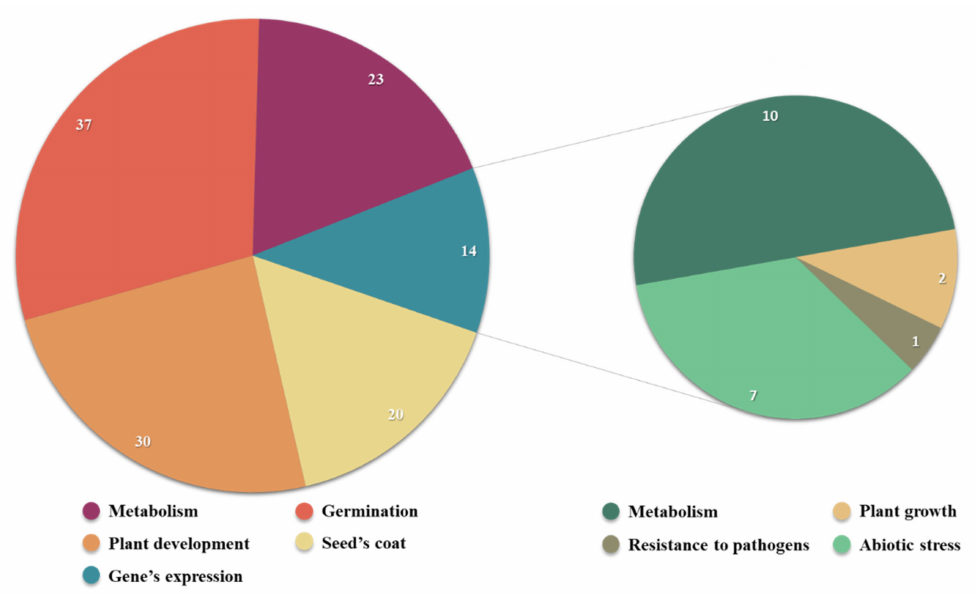
Figure 3. The frequency of the analyzed parameters in 50 scientific articles about cold plasma effects on